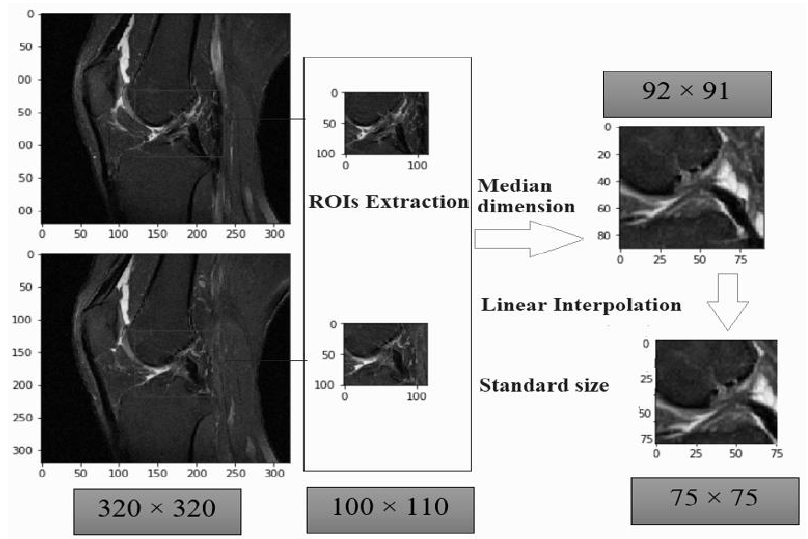
Figure 3. Region of interest-based pre-processing extraction with one standard